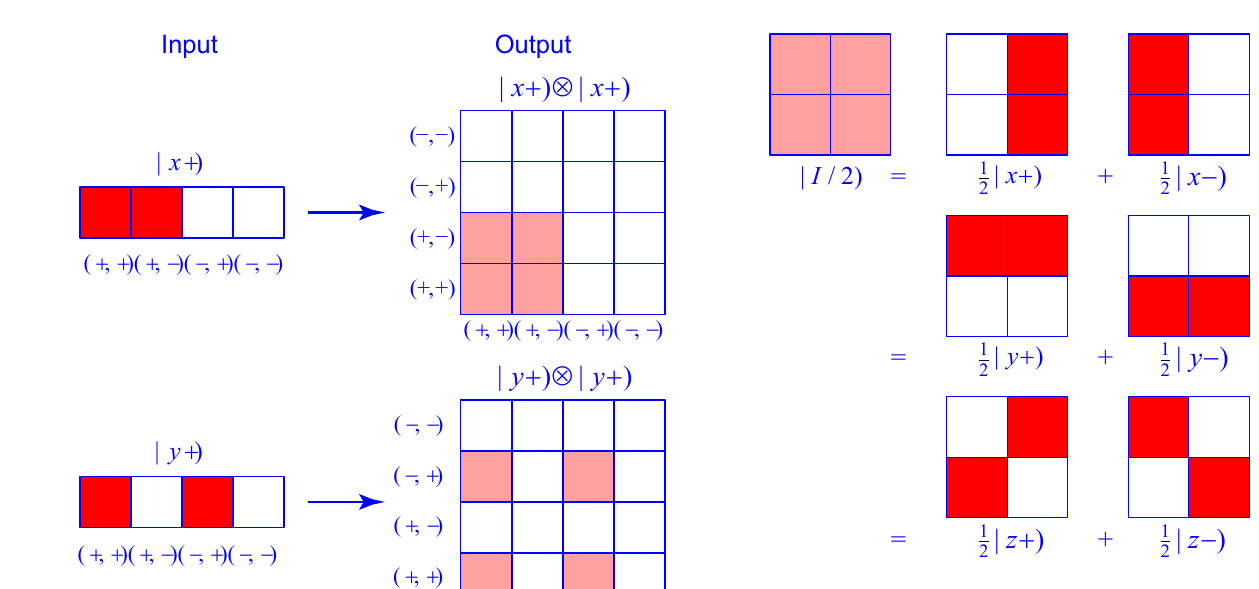
Figure 5: Multiple pure-state decompositions of a mixed state in Spekkens toy theory. The maximally mixed state | I / 2) can be written as a 50 / 50 mixture in three di ff erent ways. Light red indicates a probability of 1 / 4